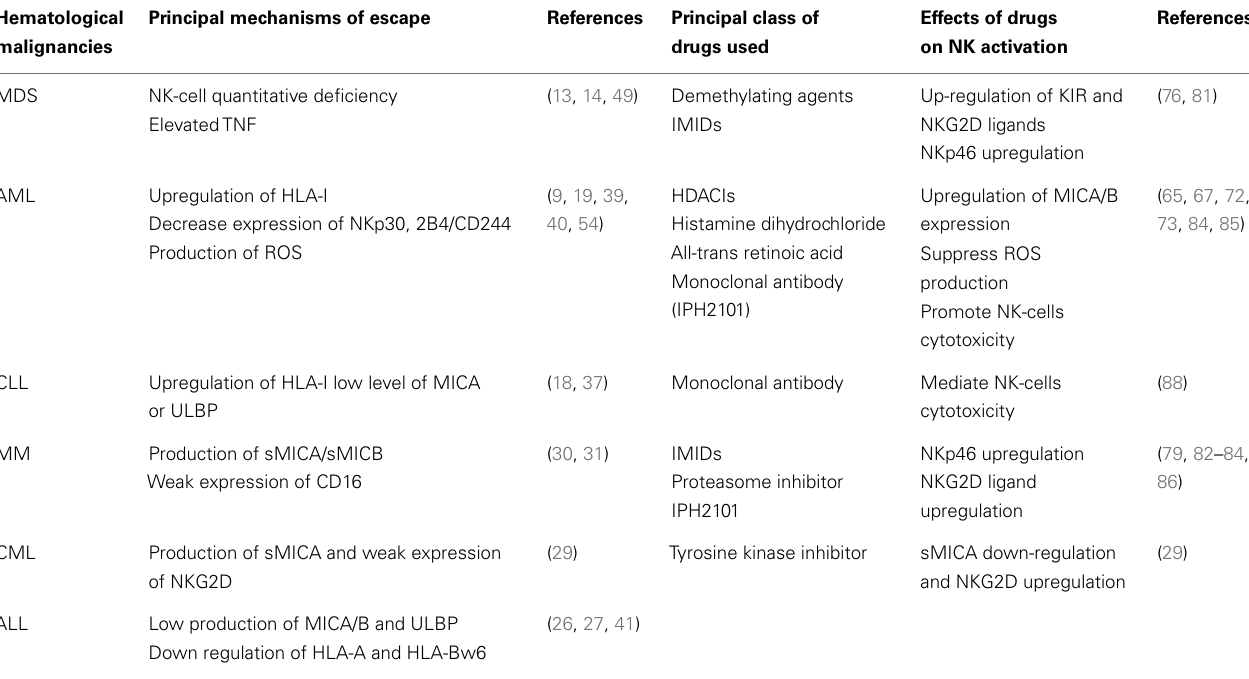
Table 1 | Mechanisms of immune escape and drugs used with their effects on NK cells in hematological malignancies.